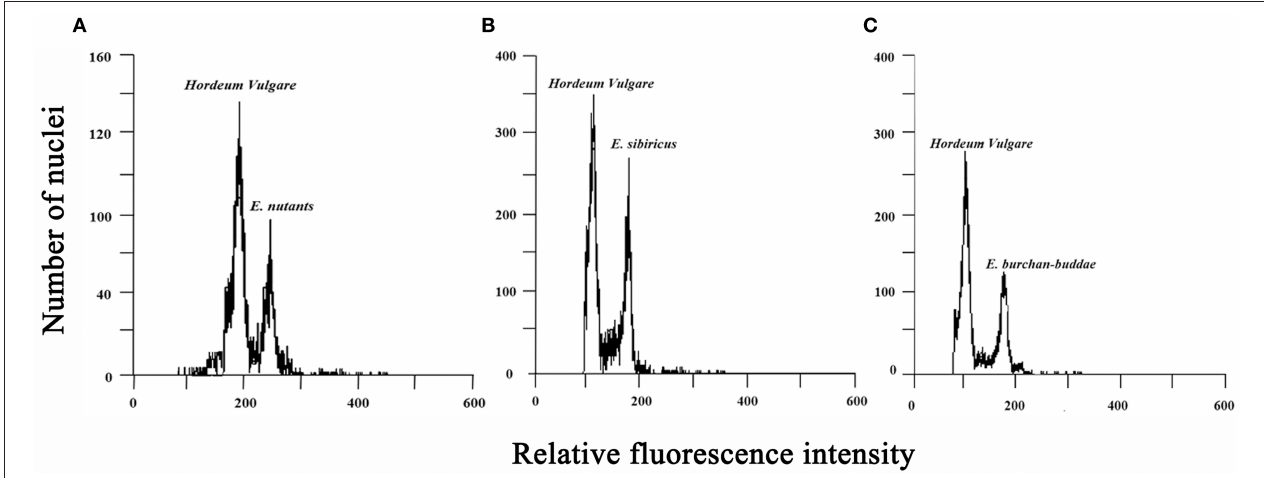
FIGURE 3 | Frequency distribution of the genome size of three Elymus species: (A) , E. nutans ; (B) , E. sibiricus ; and (C) , E. burchan-buddae . Internal standard: Hordeum vulgare L.